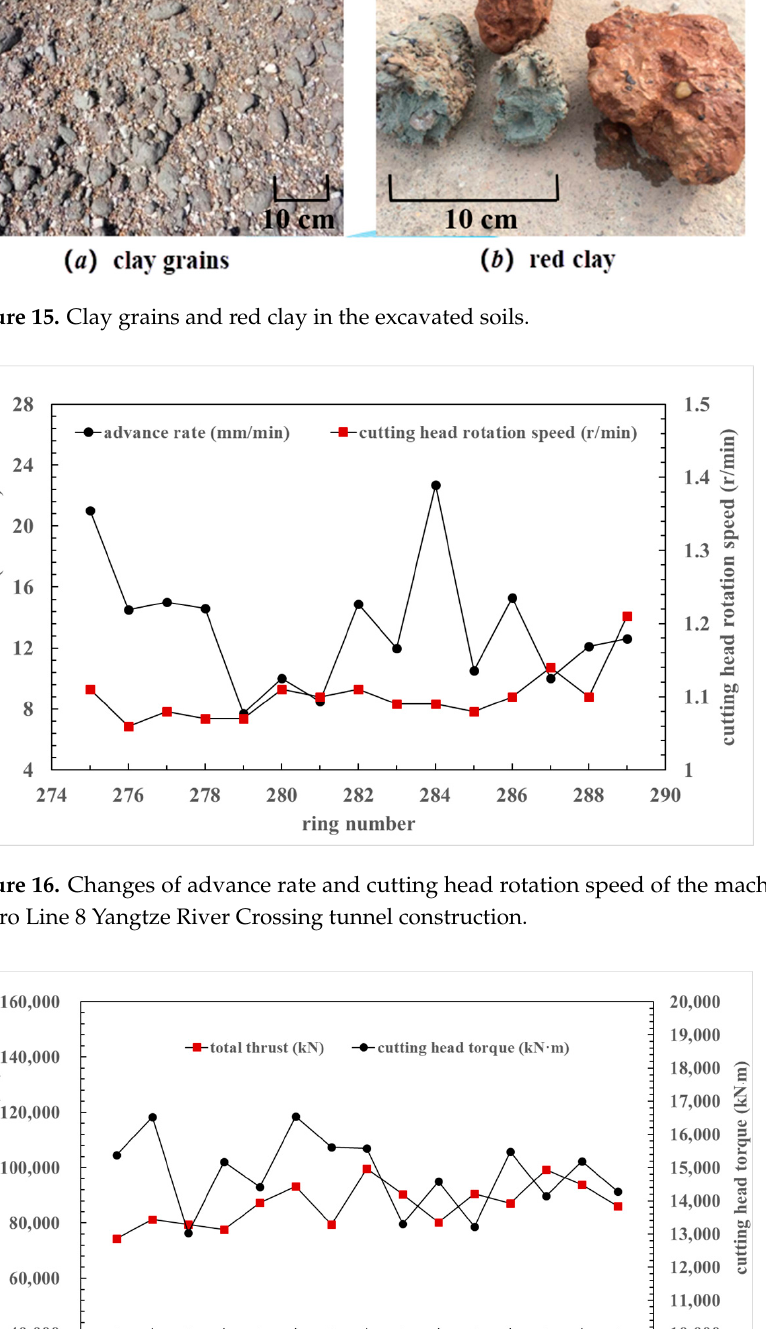
Figure 15. Clay grains and red clay in the excavated soils.